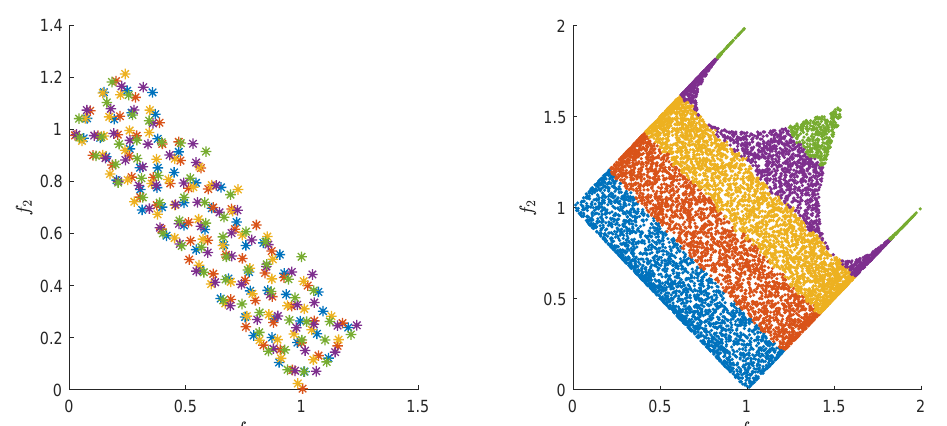
Figure 1. Ranking nearly optimal solutions for the first five ranks on Lamé superspheres MOP (LSS) with α = 0.5 [54]. The figure shows the rankings with the proposed algorithm that uses δ y ( left ) and without ( right ).